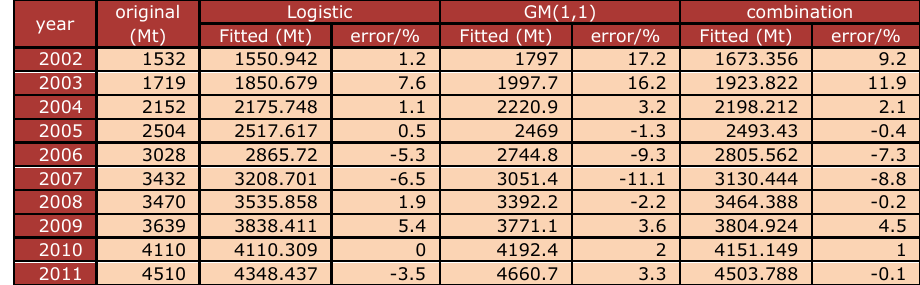
Table 2. Comparison of three